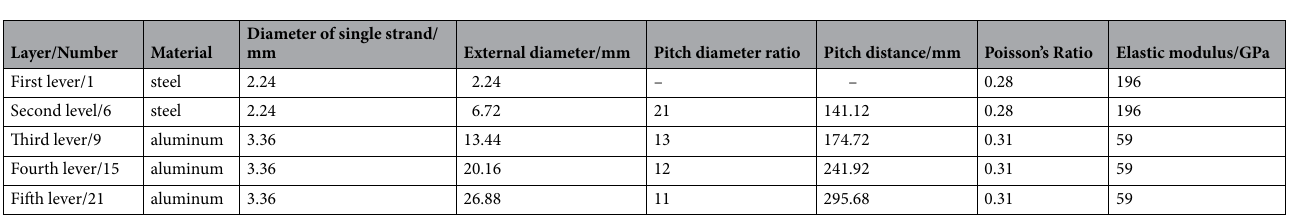
Table 1. Structural parameters of JL/G2A-400–45/7 ACSR.